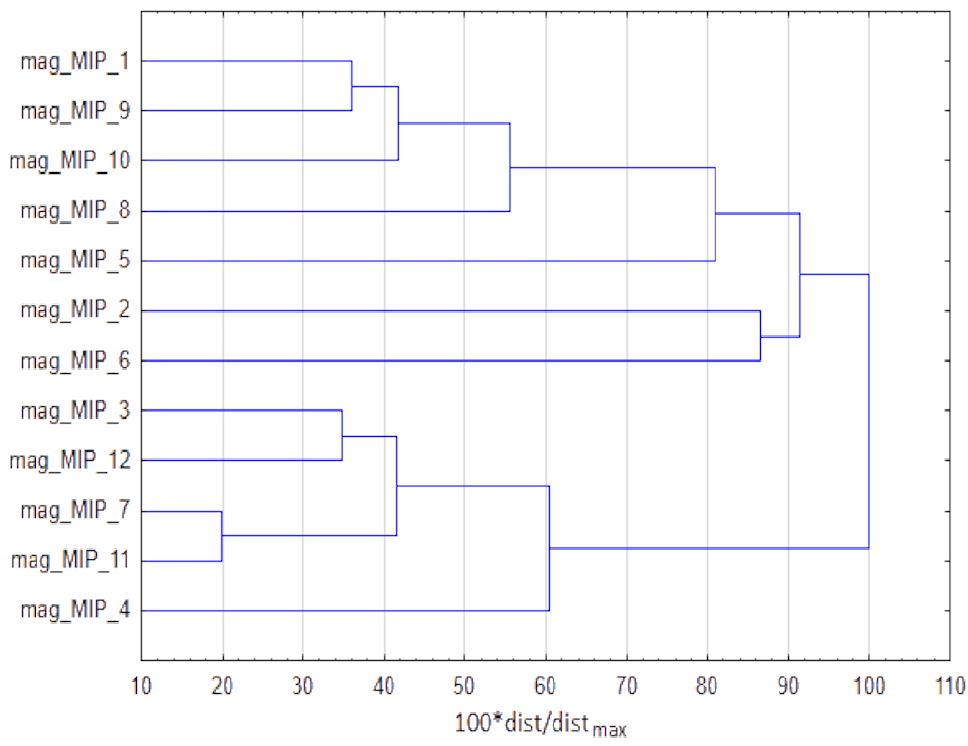
Figure 5. Grouping of procedures based on mag-MIPs, obtained with cluster analysis.